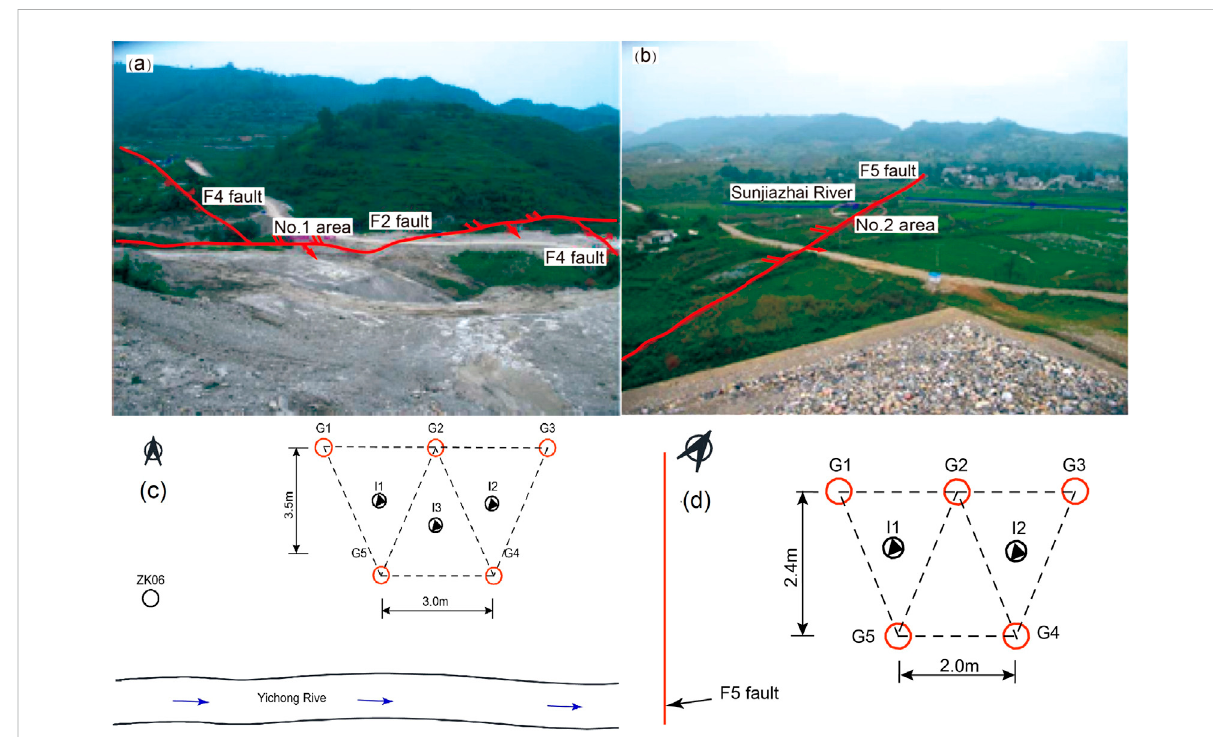
FIGURE 3 Thelocationofthetwotestareasandgroutingholearrangementin (A) No.1testarea, (B) No.2testarea, (C) arrangementinNo.1testarea,and (D) arrangement in No. 2 test